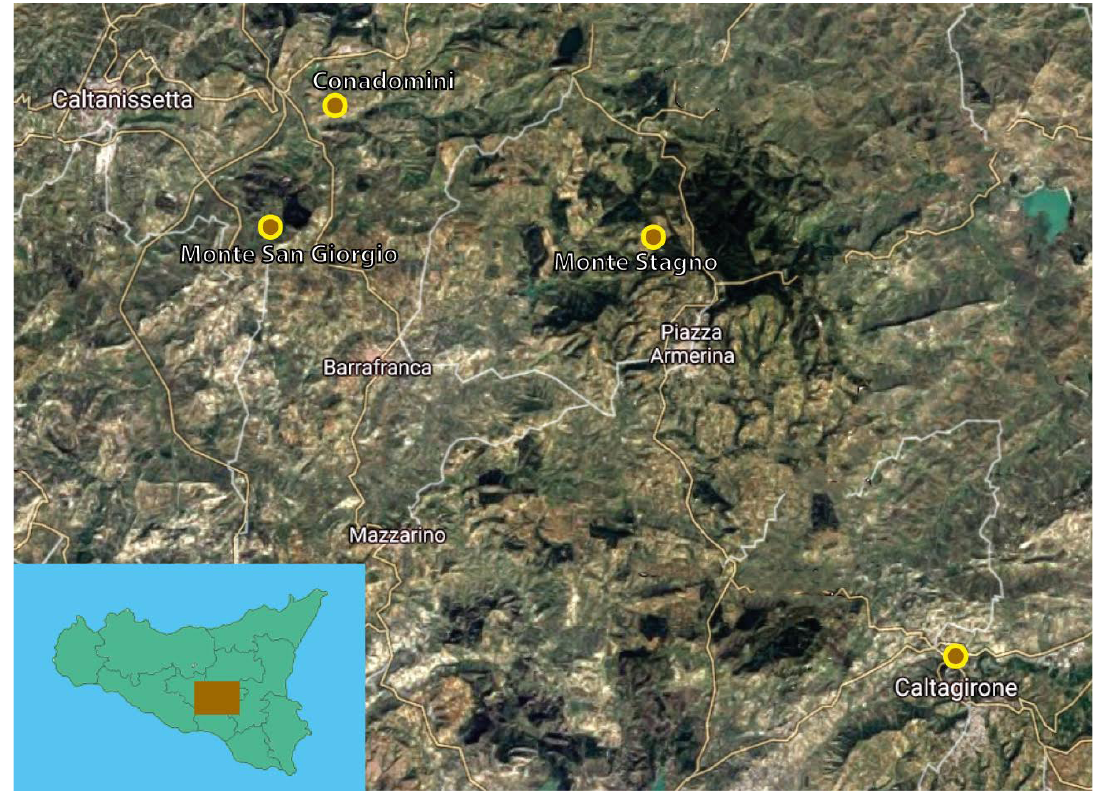
Figure 1. Geographical location of the sampling sites for the clays and quartz sand